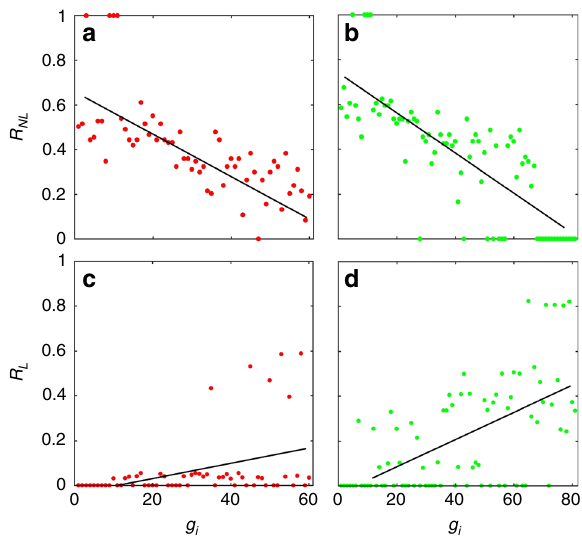
Fig. 4 Nodal importance rankings associated with nonlinear and linear control of a gene regulatory network. a , c Nonlinear and linear control importance rankings for the subnetwork of the giant component of size 60, respectively. In a , there are four nodes with R NL = 1, because controlling any of these genes will make the system recover immediately from the tipping point collapse when the direction of the change in the bifurcation parameter is reversed. For linear control in c , the size of any minimum controller set is N D = 4. b , d Nonlinear and linear nodal importance rankings for the subnetwork of 81 nodes with input connection. In b , there are several genes with R NL = 0, as each gene in this group lacks the ability to restore the entire system even when its activity level is maintained at a high level through external control. For linear control in d , any minimum controller set has N D = 17 nodes. In all panels, the nodal index along the abscissa is arranged in the descending order of the outgoing degrees of the